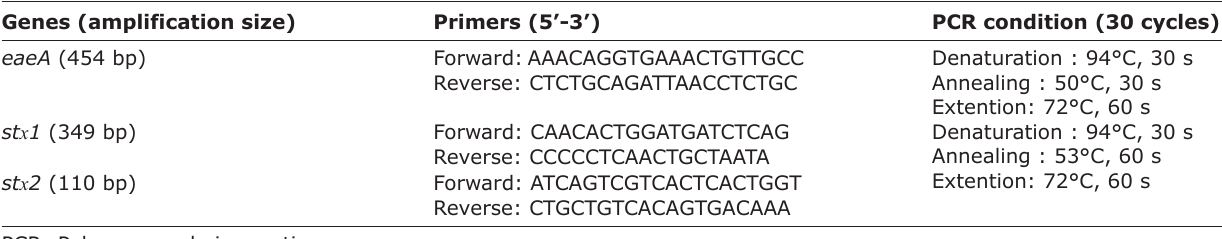
Table-1: Polymerase chain reaction primers and conditions [15]. Genes (amplification